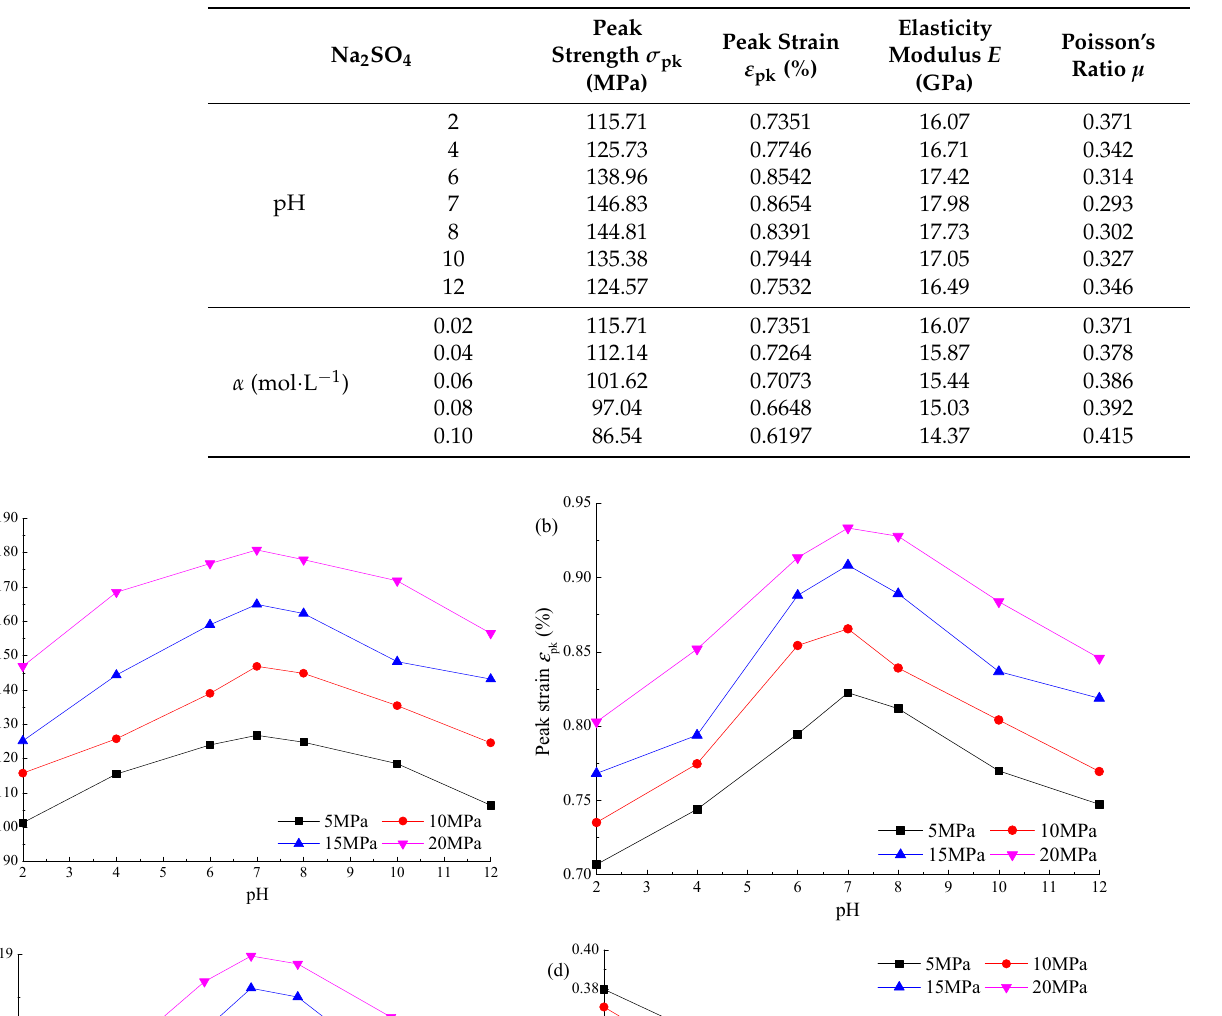
Table 2. Mechanical parameters of Na 2 SO 4 corroded sandstone ( σ 3 = 10 MPa).